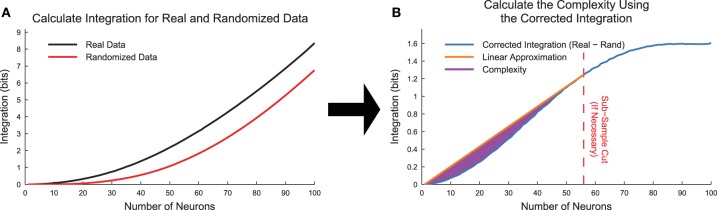
Complexity calculation algorithm. (A) Integration curves were calculated for each subset size for both real and randomized data. Frequently, the randomized data produced non-zero integration curves, indicating the presence of state sub-sampling bias. (B) To account for the sub-sampling bias, we calculated the corrected integration by subtracting the randomized integration curve from the real integration curve. In cases where the corrected integration curve was not uniformally concave up due to sub-sampling, we utilized an automated method to apply a cut and thereby limit the system size based on the available data. The complexity (Equation 21) is represented by the area between the linear approximation and the corrected integration curve. The data for this explanatory figure was taken from the cortical branching model.